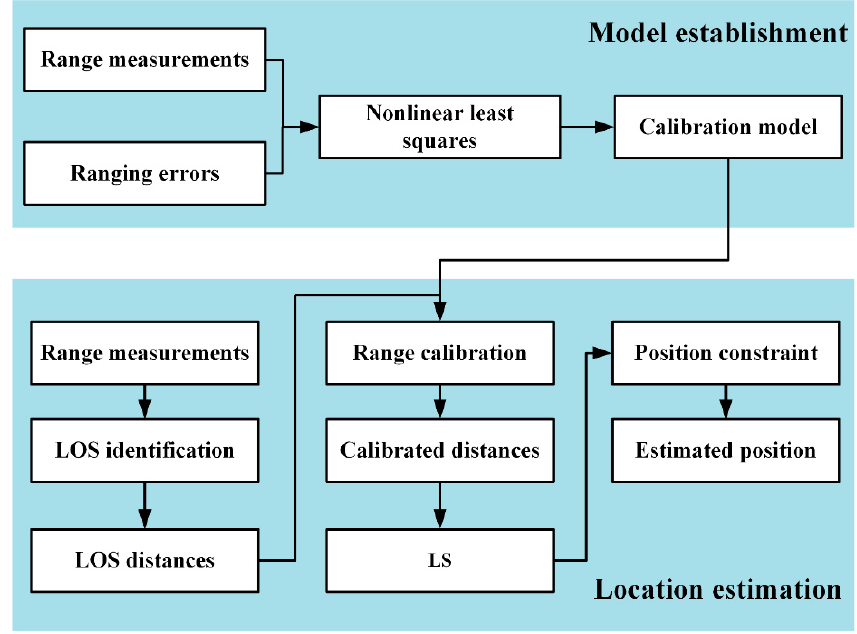
Figure 5. The principle of the proposed method.